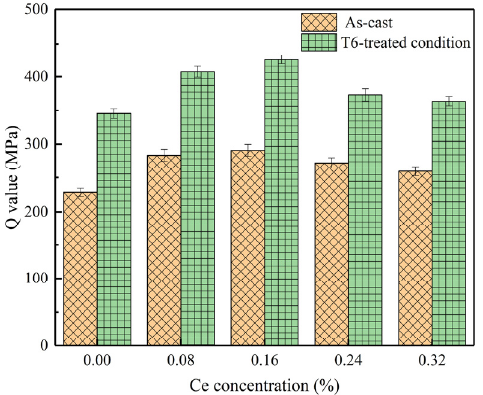
Figure 14. Q value of the experimental steel treated by different processes.